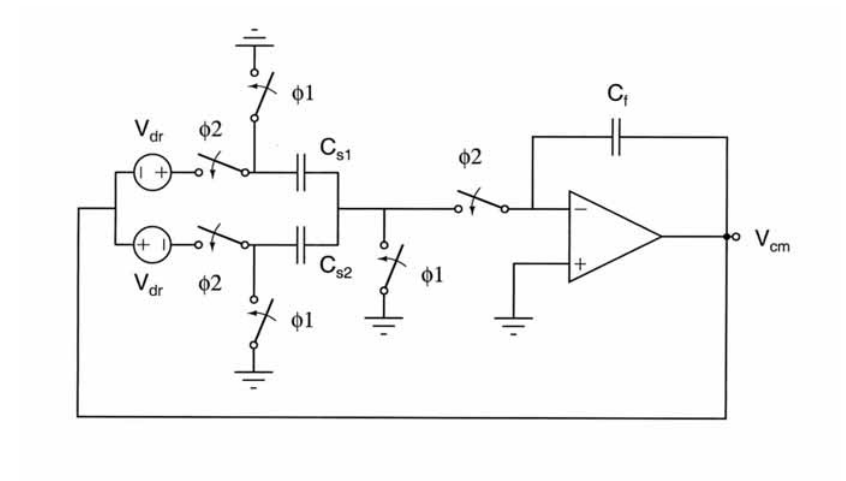
Fig. 3. Interface circuit